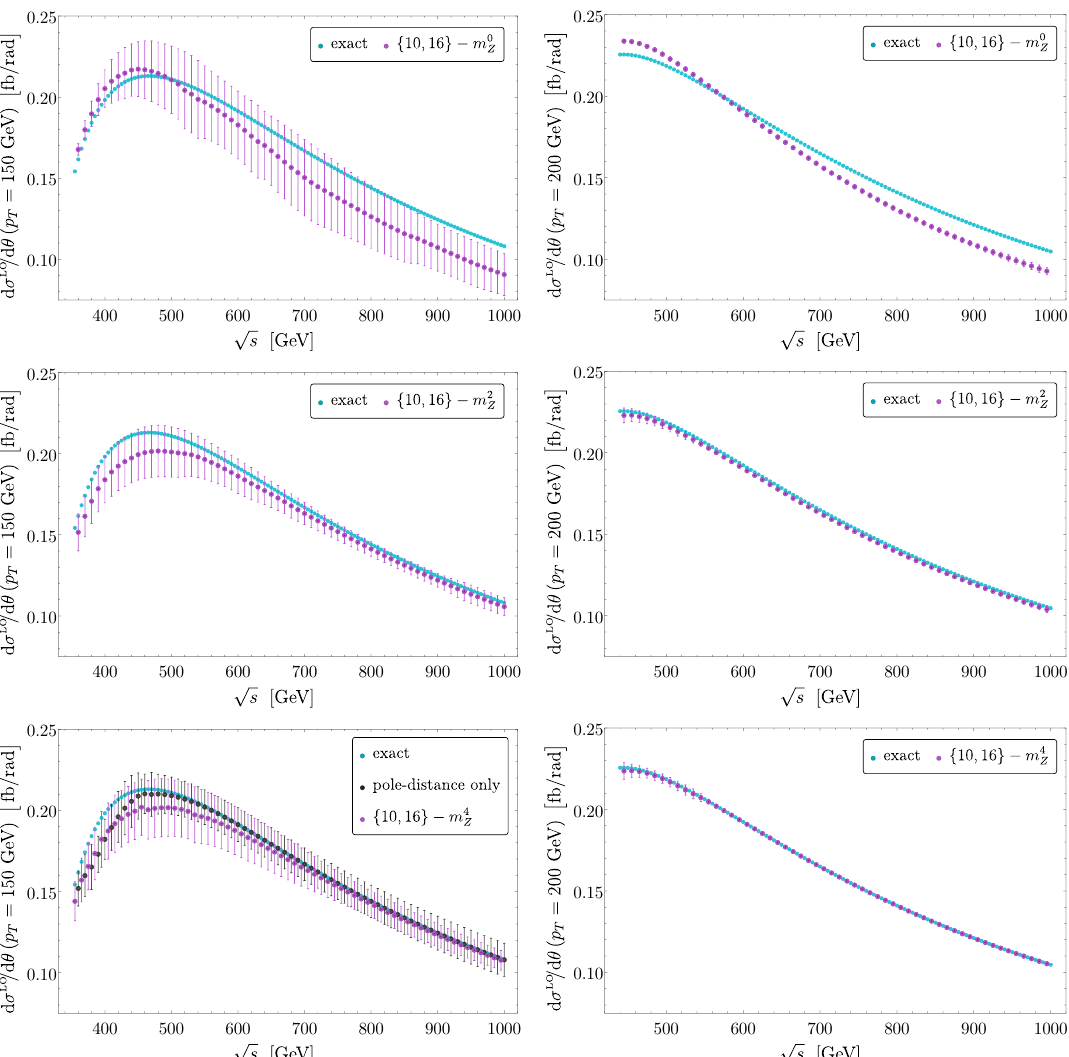
Figure 5 . LO partonic di(cid:11)erential cross section for gg ZZ for p T = 150 GeV (left column) and ! p T = 200 GeV (right column) as a function of p s . The blue points are the exact result, and the purple points are the central values with uncertainties according to the prescription of eq. (4.9). The bottom left plot shows additionally central values and uncertainties according to eq. (4.4). The (cid:12)rst, second and third rows show Pad(cid:19)e approximants constructed from expansions including terms to m 0 , m 2 and m 4 , respectively. Z Z Z